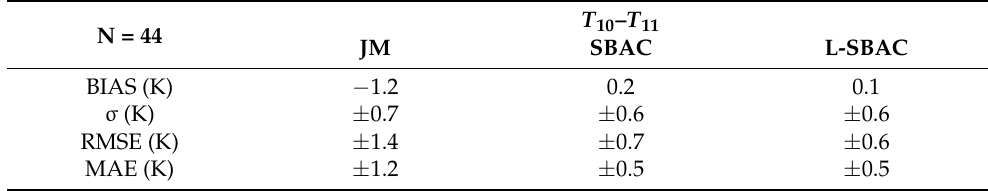
Table 6. Statistics of the differences in terms of derived LST using bands 10 and 11 as inputs in the SC algorithms ( T 10 – T 11 ) for the full validation database. Jimenez-Muñoz (JM), SBAC, and Linear SBAC (L-SBAC) methodologies are